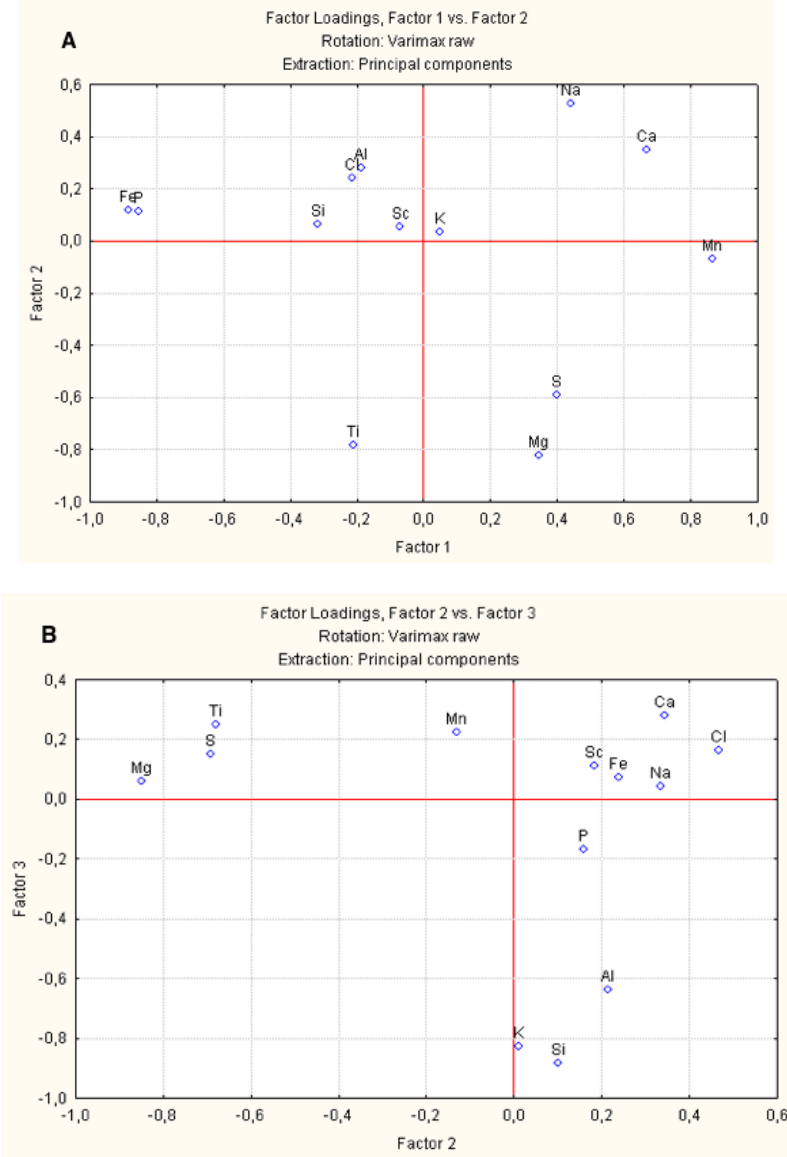
Figure 6. Three factor loadings of selected elements concentrations of ferromanganese colloform matrix. Varimax raw rotation of factors has been applied. ( A ) Factor 1 vs. Factor 2, ( B ) Factor 2 vs. Factor 3.